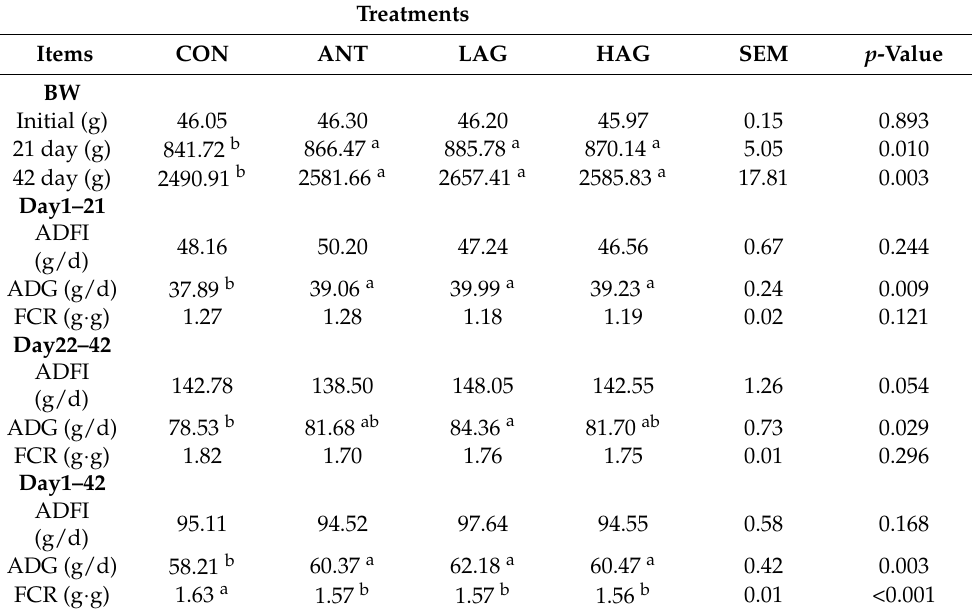
Table 1. Effects of Astragalus-Glycyrrhiza polysaccharides on broiler performance.